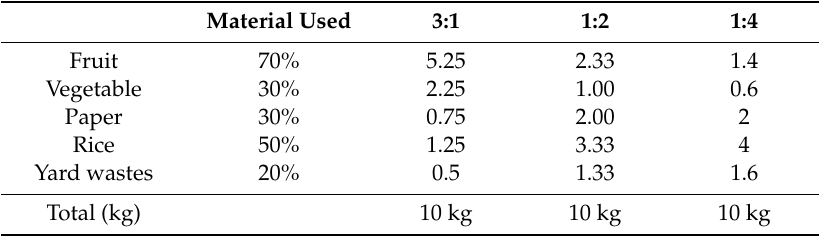
Table 3. Formulation ratios and weights (kg) of FVW and BMW used in